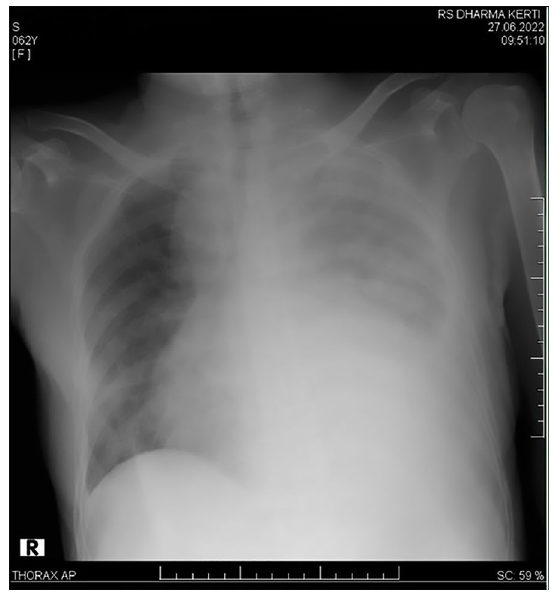
Fig. 2 Chest radiograph showed left massive pleural